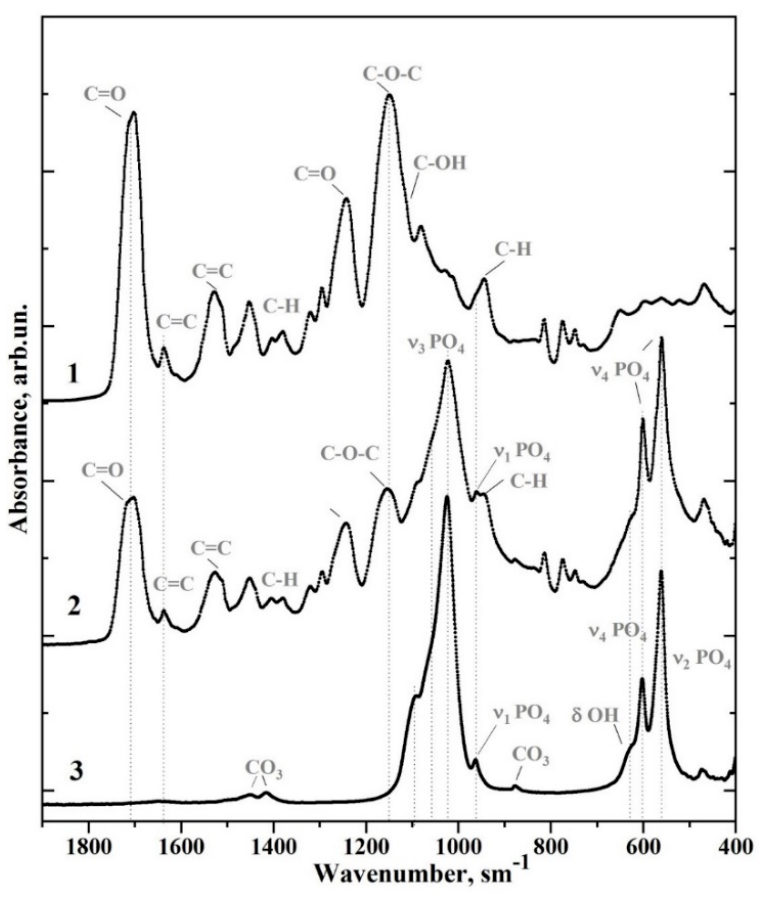
Figure 3. FTIR spectra of the (1) original Bis-GMA adhesive, (2) nanocrystalline carbonate-substituted calcium hydroxyapatite (nano-cHAp) and (3) sample #1 Bis-GMA/nano-cHAp (0.2 g).